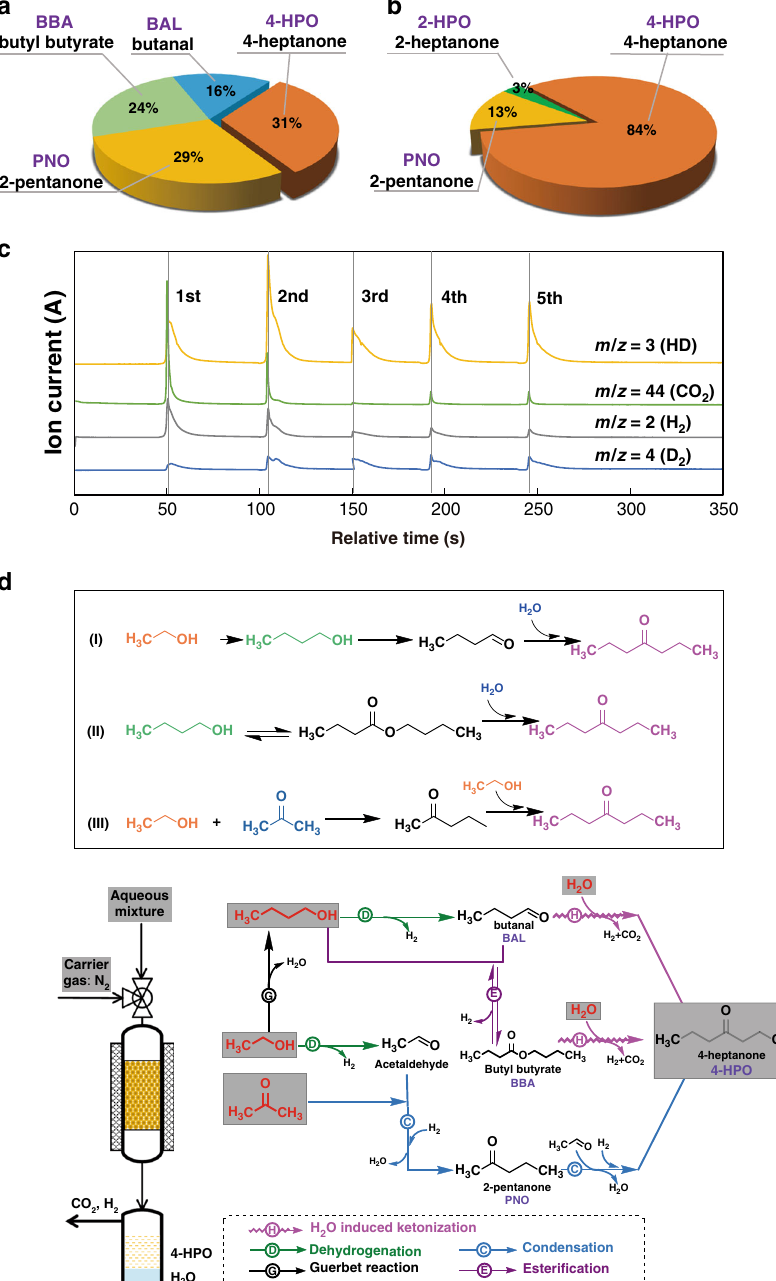
Fig. 1 The catalytic function of water in ABE aqueous solution conversion reaction and proposed reaction pathways. a ABE as feedstock (A:B:E weight ratio is 9:51:1). b ABE with water as feedstock (A:B:E:H 2 O weight ratio is 9:51:1:22). Reaction conditions: ceria (16.0 g, 14 – 25 mesh), N 2 as carrier gas ( fl ow rate = 14 – 25 mesh), 10 μ L per injection of n -butanol and D 2 O mixture, Ar as carrier gas ( fl ow rate = 30 mL min − 1 ), 400 °C. The fl uctuation of each pulse is due to non-uniform sampling of butanol for each injection (from butanol/D 2 O emulsion mixture). d Proposed reaction pathways leading to 4-HPO in a fi xed-bed reactor with acetone, n -butanol, ethanol, and water as feedstock over ceria-based